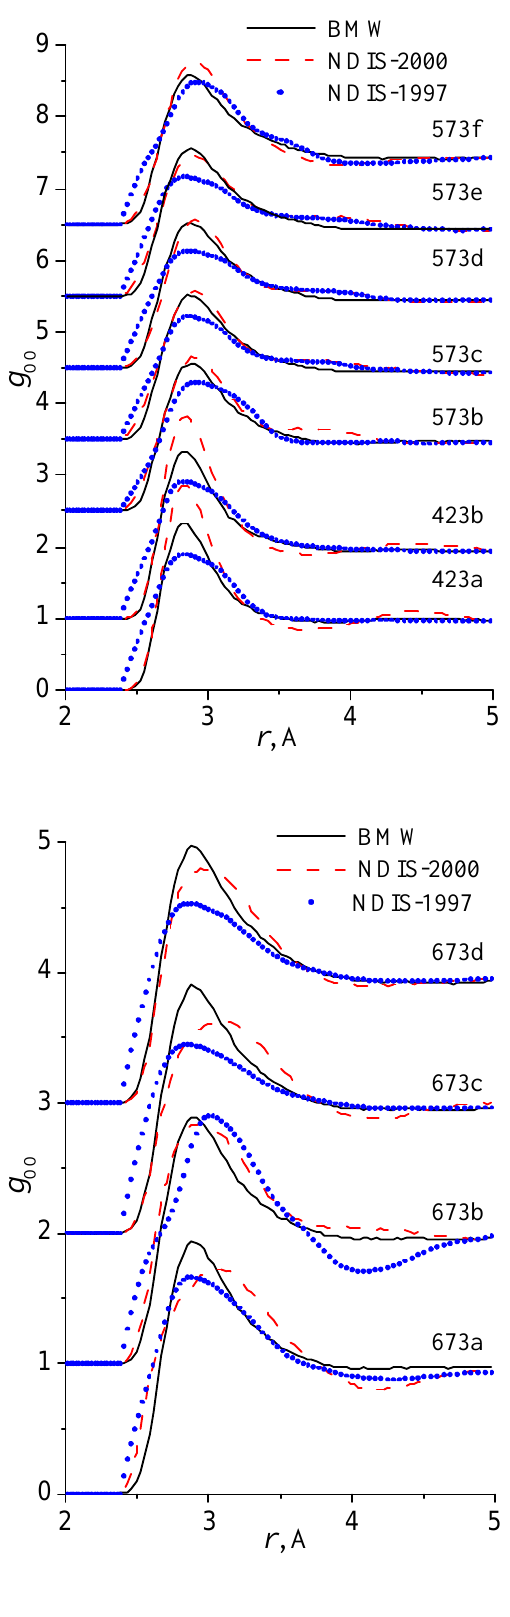
Figure 9. Radial distribution functions g Graphics are shifted along the y-axis for